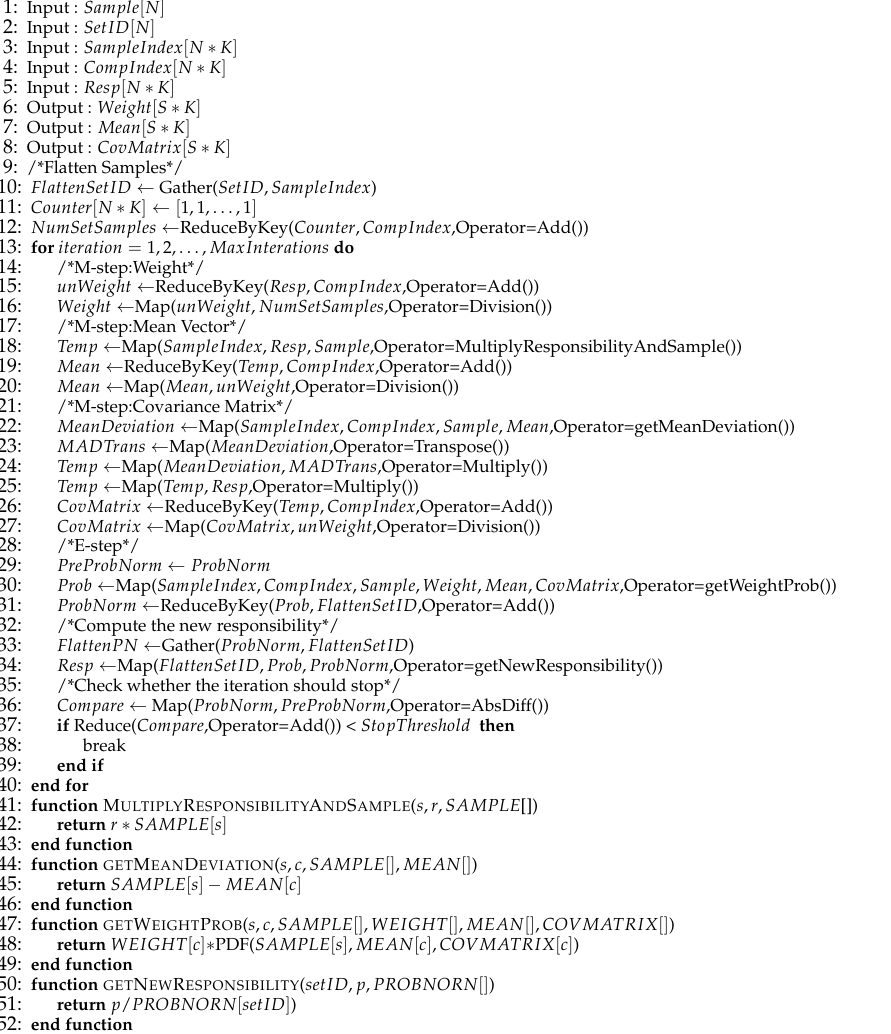
Algorithm 5 DPP Version of the Multi-set EM Algorithm for Shared Memory